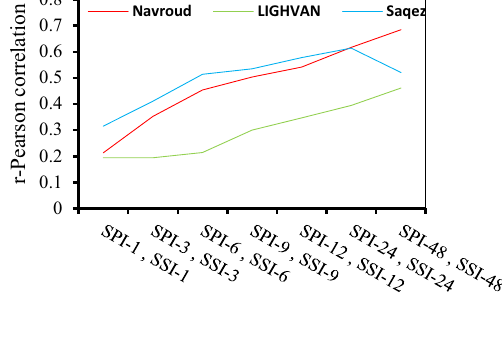
Fig. 3 Pearson correlation coefficients between indices for 1–48